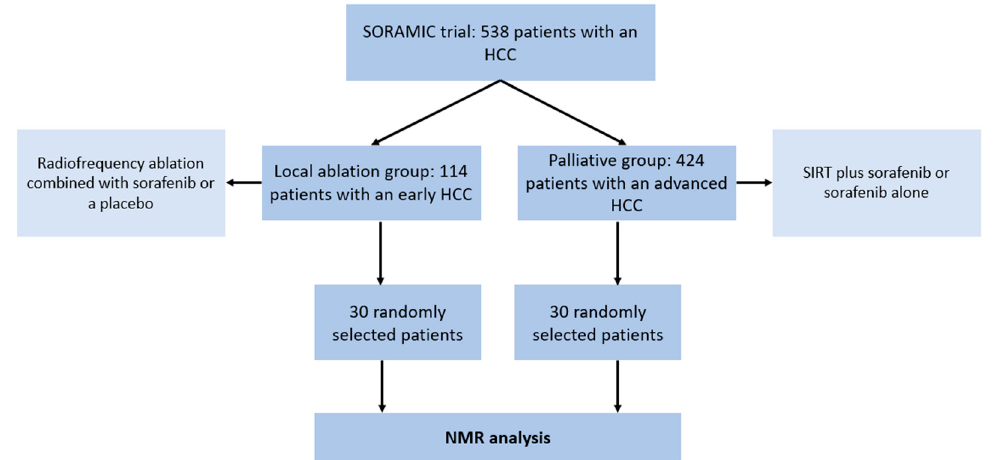
Figure 1. Flowchart illustrating the patient cohorts in the SORAMIC trial and the selection of patients for the present study. HCC = hepatocellular carcinoma. NMR = nuclear magnetic resonance. SIRT = selective internal radiation therapy.